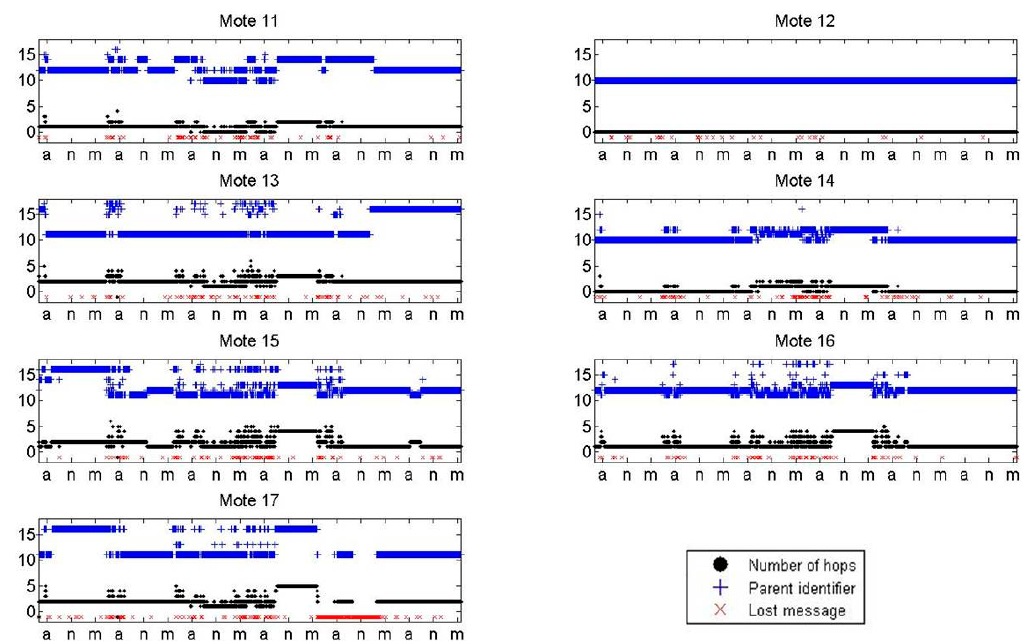
Figure 11. Lost messages (red color), number of hops made for a message to reach the base station (black color), and parent identifiers (blue color) with respect to time for each mote. Data corresponds to the XMESH protocol in Experiment 1. In the x-axis, “m” means morning, “a” is afternoon, and “n” is night.